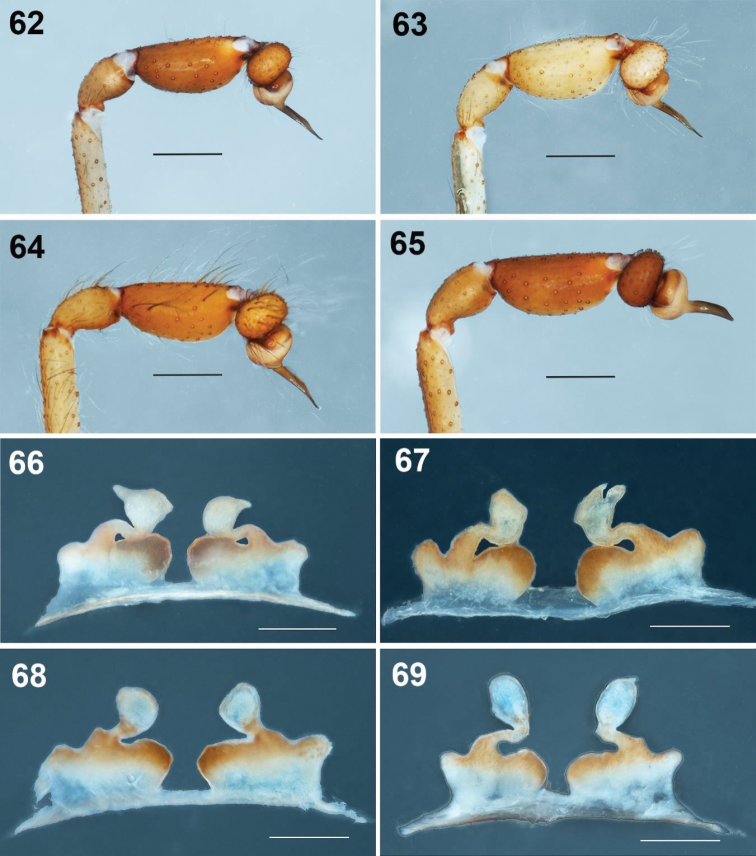
Loxosceles
misteca Gertsch, 1958 62–65 variation of the male palps, left palps, prolateral views 62 Grutas General Carlos Pacheco, Municipality Pilcaya, Guerrero 63 Cueva del Diablo Acuitlalpan, Municipality Taxco, Guerrero 64 boulevard Cuauhtémoc #99, Colonia Lomas de Cortes, Municipality Cuernavaca, Morelos 65 Grutas de Cacahuamilpa National Park, Municipality Pilcaya, Guerrero 66–69 variation of the seminal receptacles of the females, dorsal views 66, 67 Agustin Lorenzo Cave, Mexcaltepec, Municipality Taxco de Alarcón, Guerrero 68, 69 Botanical Garden Cave, Grutas de Cacahuamilpa National Park, Municipality Pilcaya, Guerrero.